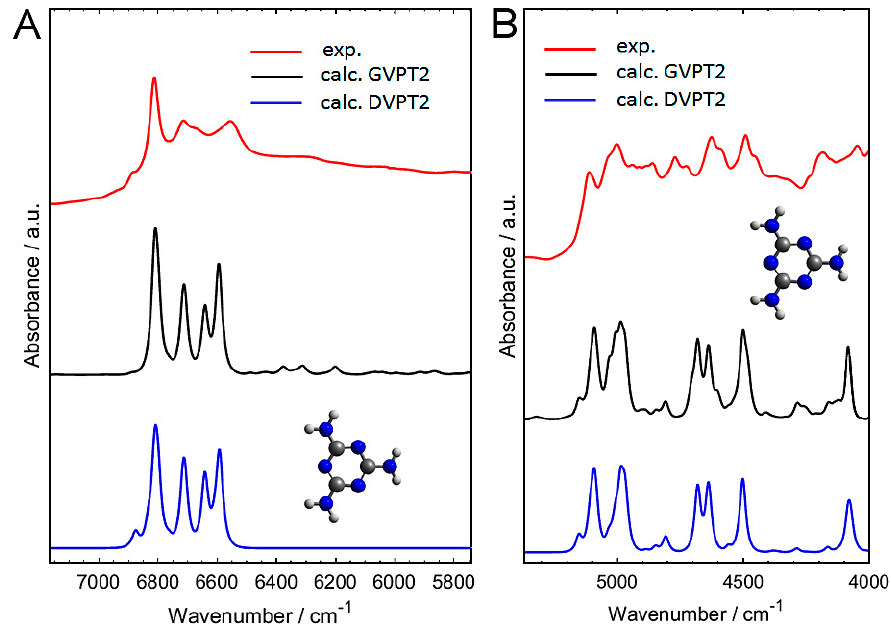
Figure 4. Comparison of the experimental diffuse reflectance near-infrared (NIR) spectrum of polycrystalline melamine with the calculated spectra. The spectra were calculated at B3LYP-GD3BJ/SNST level for an isolated molecule in two different anharmonic approximations (DVPT2 and GVPT2). In the GVPT2 calculation second overtones and ternary combinations were also included. ( A ) 7150–5750 cm − 1 region; ( B ) 5400–4000 cm − 1 region.